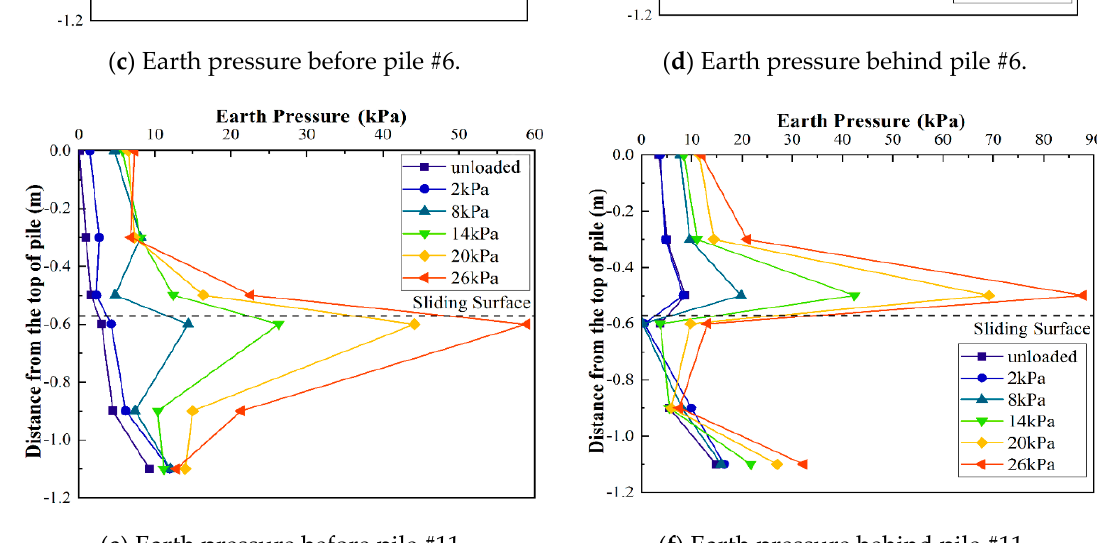
Table 4. The earth pressure sharing ratio of each row of piles (static model test).